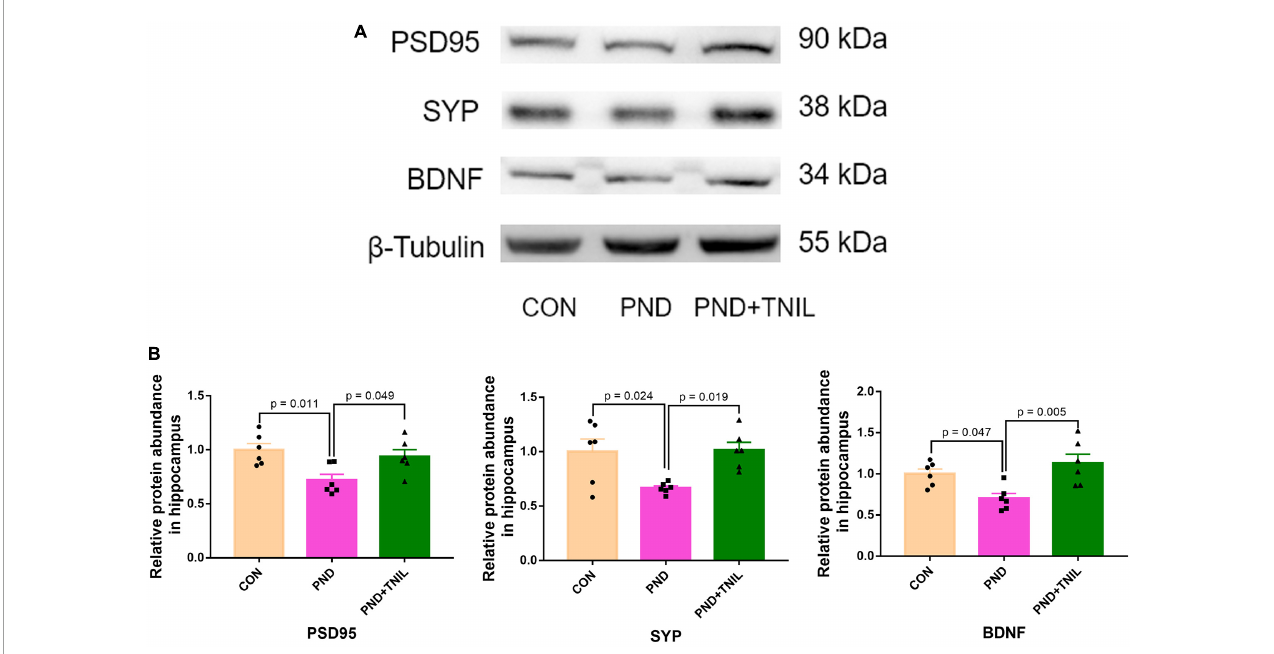
FIGURE5 Transcranial near-infrared laser improved hippocampal synaptic dysfunction of aged mice with PND. (A) Representative Western blots of PSD95, SYP, and BDNF in the hippocampus. (B) Relative protein expression of PSD95, SYP, and BDNF in the hippocampus. Data are shown as mean ± SEM.